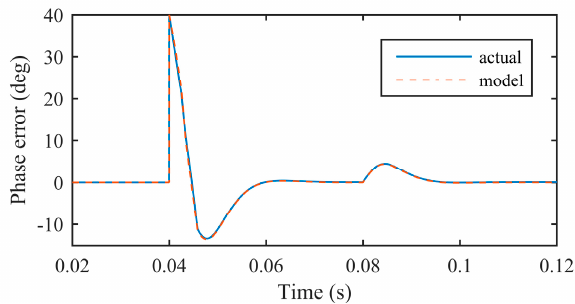
Figure 17. The transient response of the proposed PLL (solid line) and its mathematics model (dashed line) under +40° phase jump (at 0.04 s) and +5 Hz frequency jump (at 0.08 s).